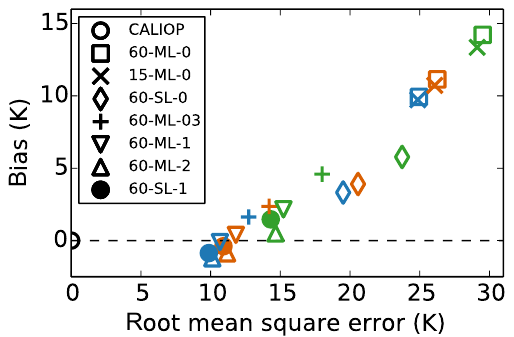
Figure 3. Bias (SEVIRI minus CALIOP CTT) versus root mean square error of SEVIRI cloud top temperature retrievals. Symbols refer to the different sets of collocation criteria, defined in Table 1. Green symbols show retrievals over land, blue over ocean, and or- ange over both. The “CALIOP” point on the left-hand side indicates where a retrieval which perfectly reproduces the CALIOP observa- tions would be located.